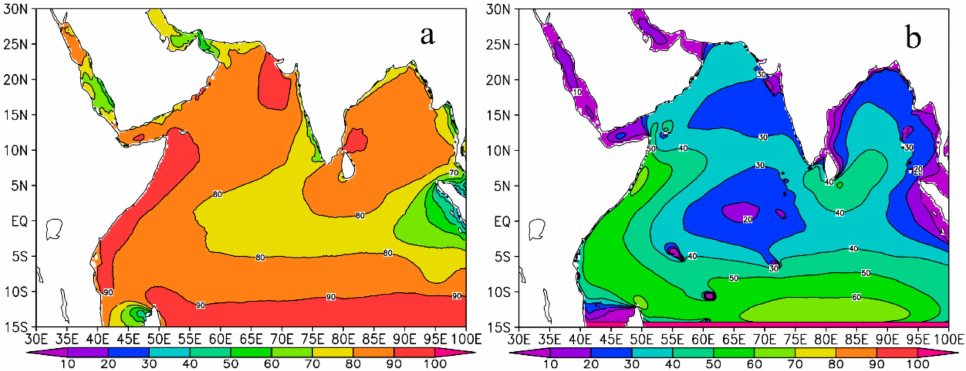
Figure 4. Occurrence of 10-year average exploitable WS (unit: %) ( a )and exploitable SWH (unit: %) ( b